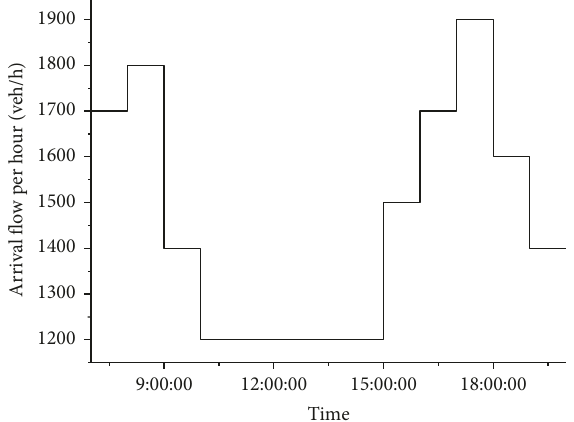
Figure 6: Dynamic distribution of the upstream arrival flow on Fenghua Road. Table 2: Traffic characteristic parameters of the heaviest